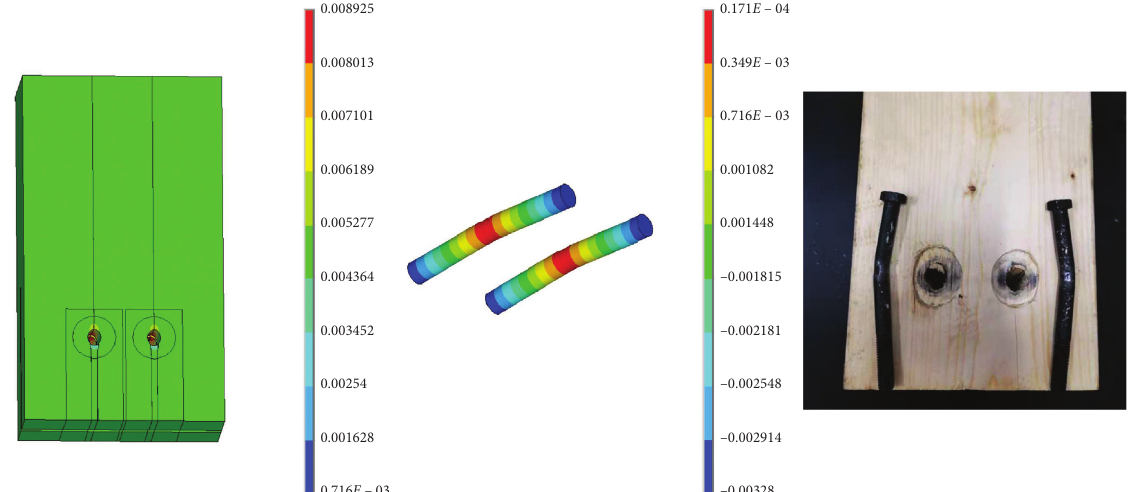
Figure 8: Failure modes of bolted glulam joint obtained from numerical analysis and experiment.